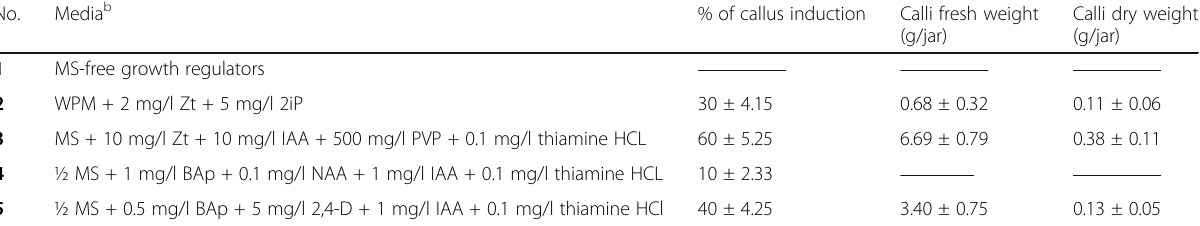
Table 2 Effect of different type of nutrient media on percentage of calli induction calli fresh, and dry weights (g/jar) induced from internode explants of Diospyros kaki L. cv. Costata a